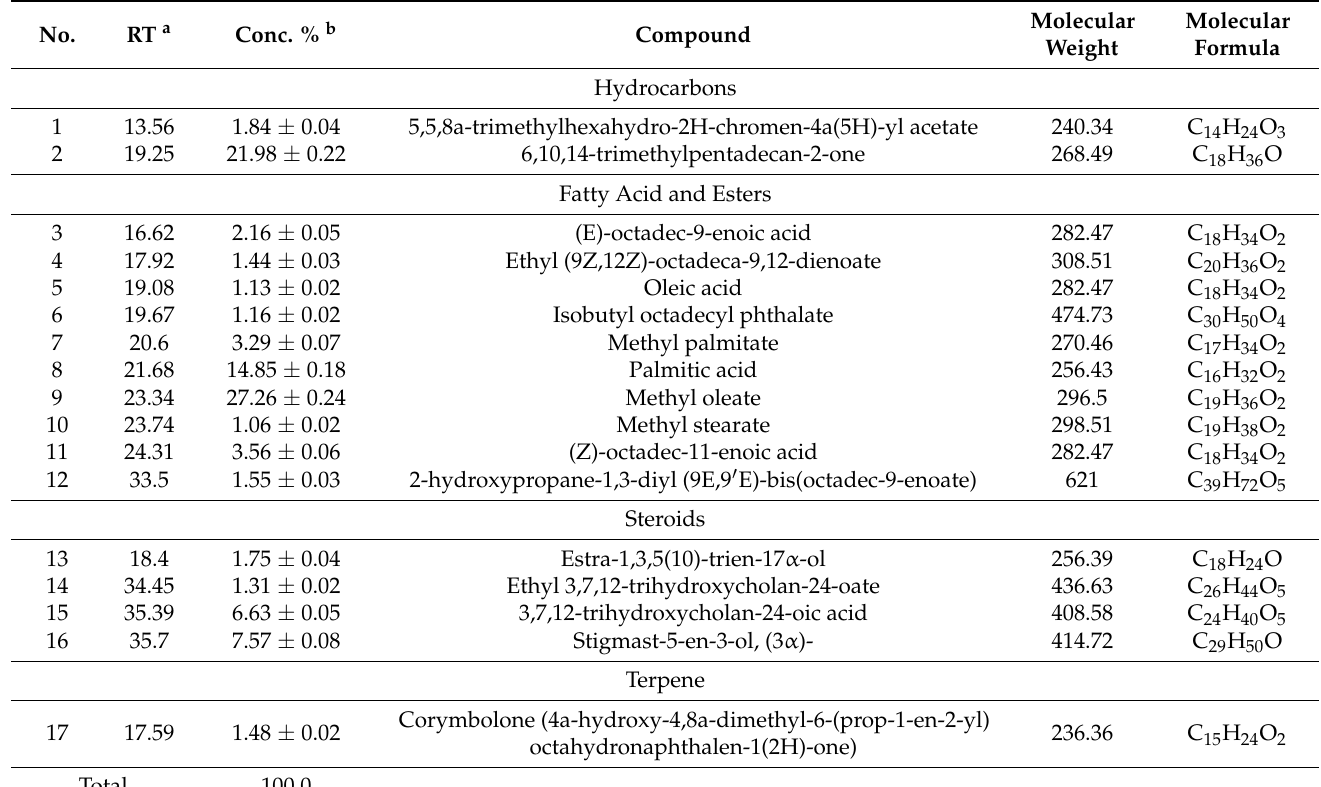
Table 1. The characterized chemical components were isolated from the extracted shoots of R. tingitana .